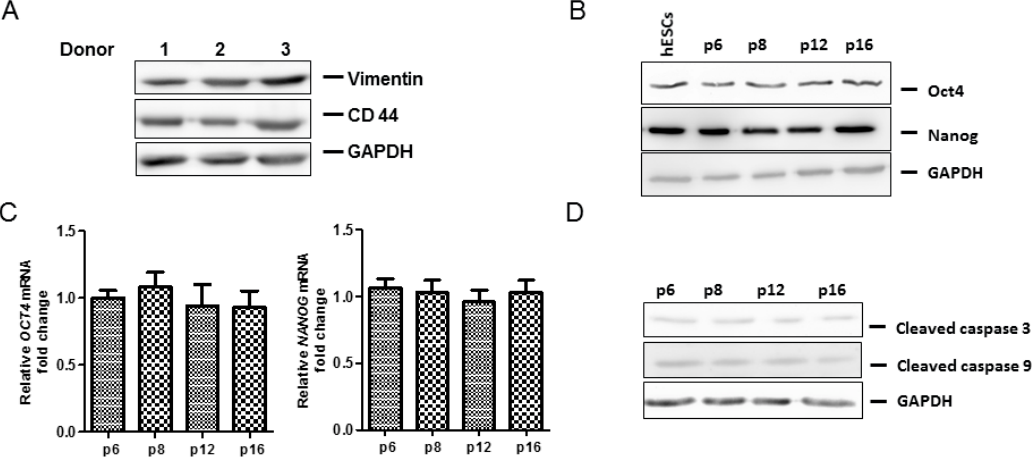
Figure 3. Cont. Figure 3. Cont.